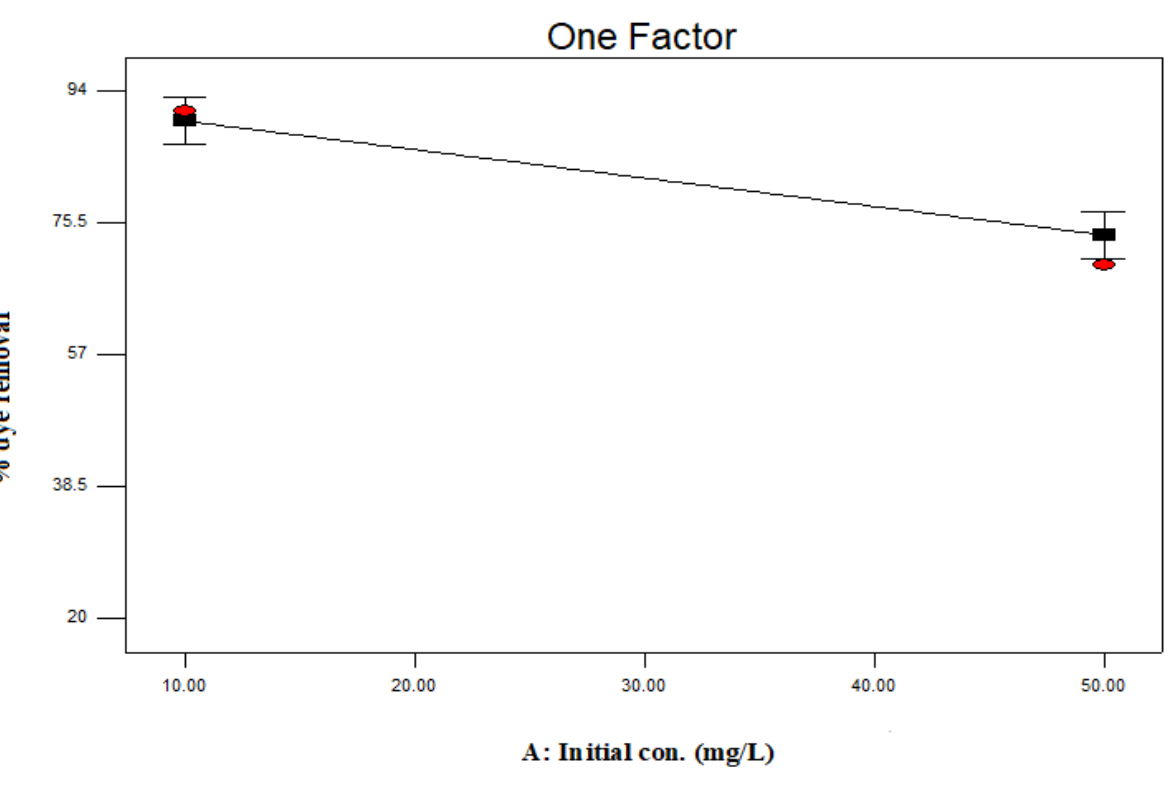
Figure 7. Influence of the initial concontration on the perecentage MB removal at a constant pH (B) of 9, adsorbent dose (C) of 200 mg/L, and time (D) of 89.75 min.